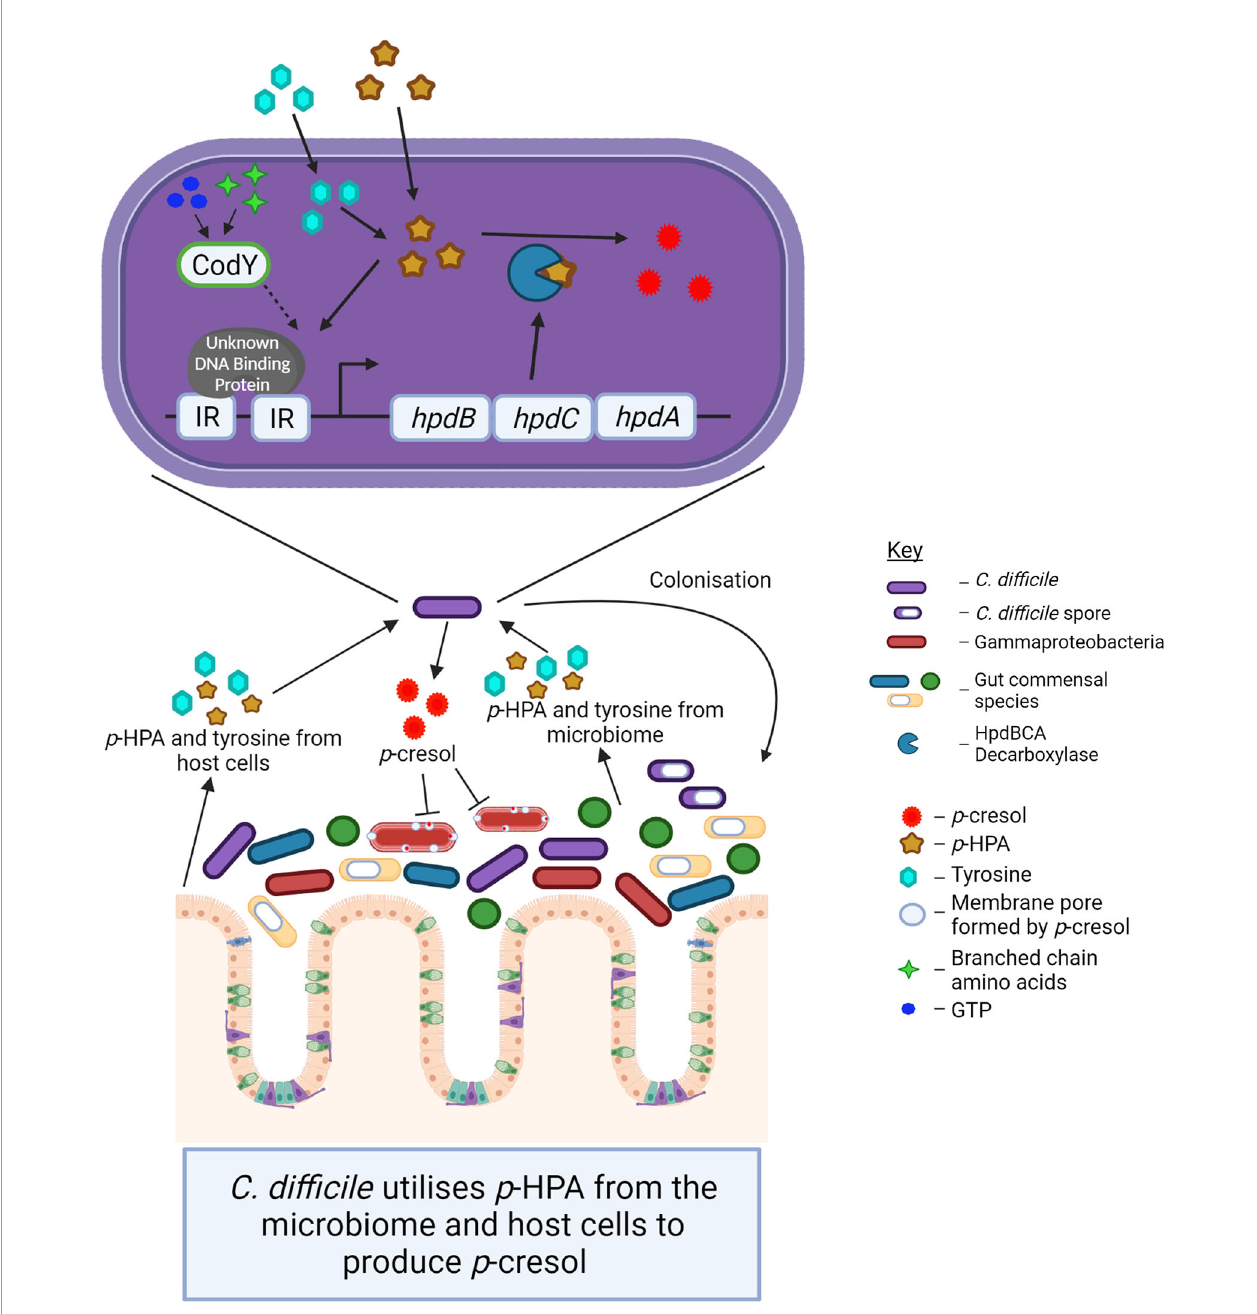
FIGURE 8 | The schematic indicates the interconnected roles of the microbiome and host cells in p -cresol production by C. dif fi cile and the impact of p -cresol production on the Gram-negative Gammaproteobacteria within the host microbiome.